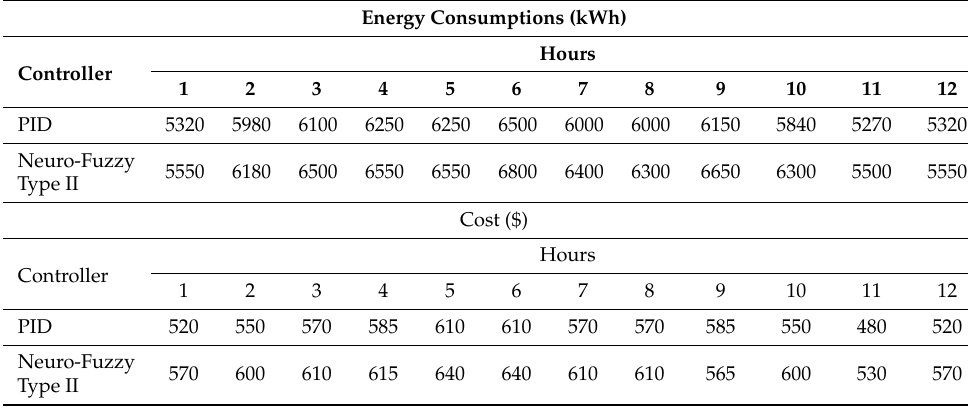
Figure 11. ( a ) EC and ( b ) energy cost of PID and adaptive NF-II control system. Table 3. Benefits Comparison (calculating error) between open loop and closed loop controller (PID, Neuro-Fuzzy Type II) Energy consumptions and